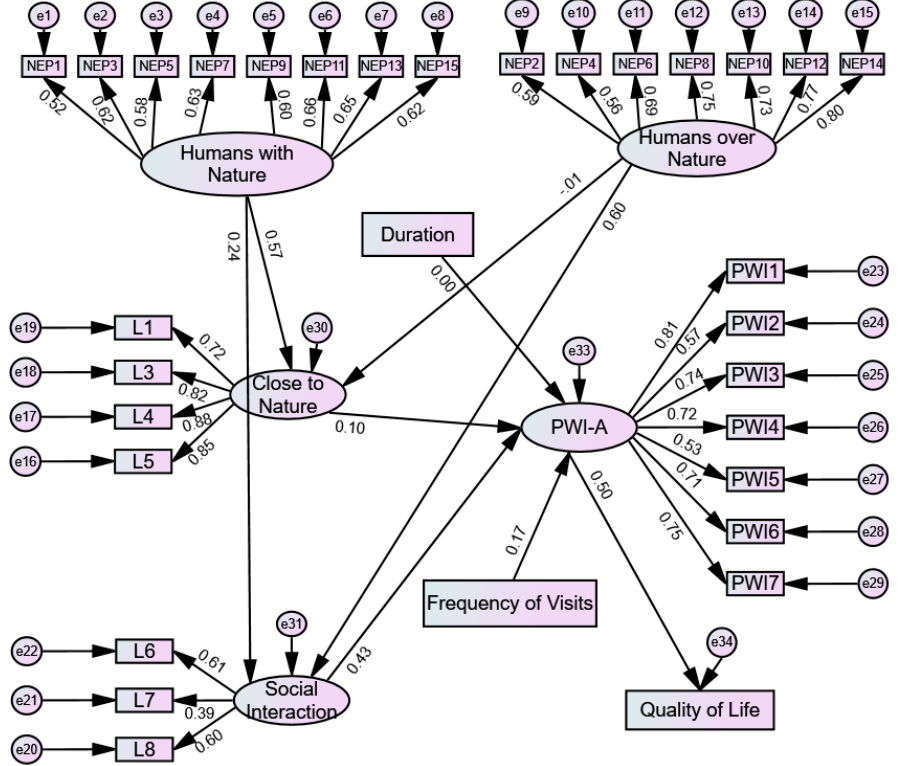
Figure 3. Structural equation model for the 2019 sample.